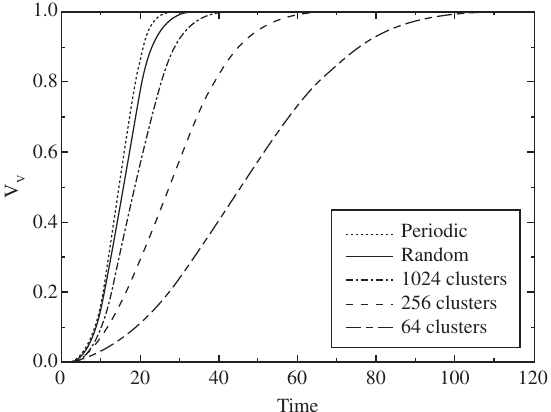
Figure 3. Volume fraction against time, simulated by CA. The reaction is faster for a periodic nuclei arrangement and slower for clusters. The number of nuclei per unit of volume is the same in all simulations.